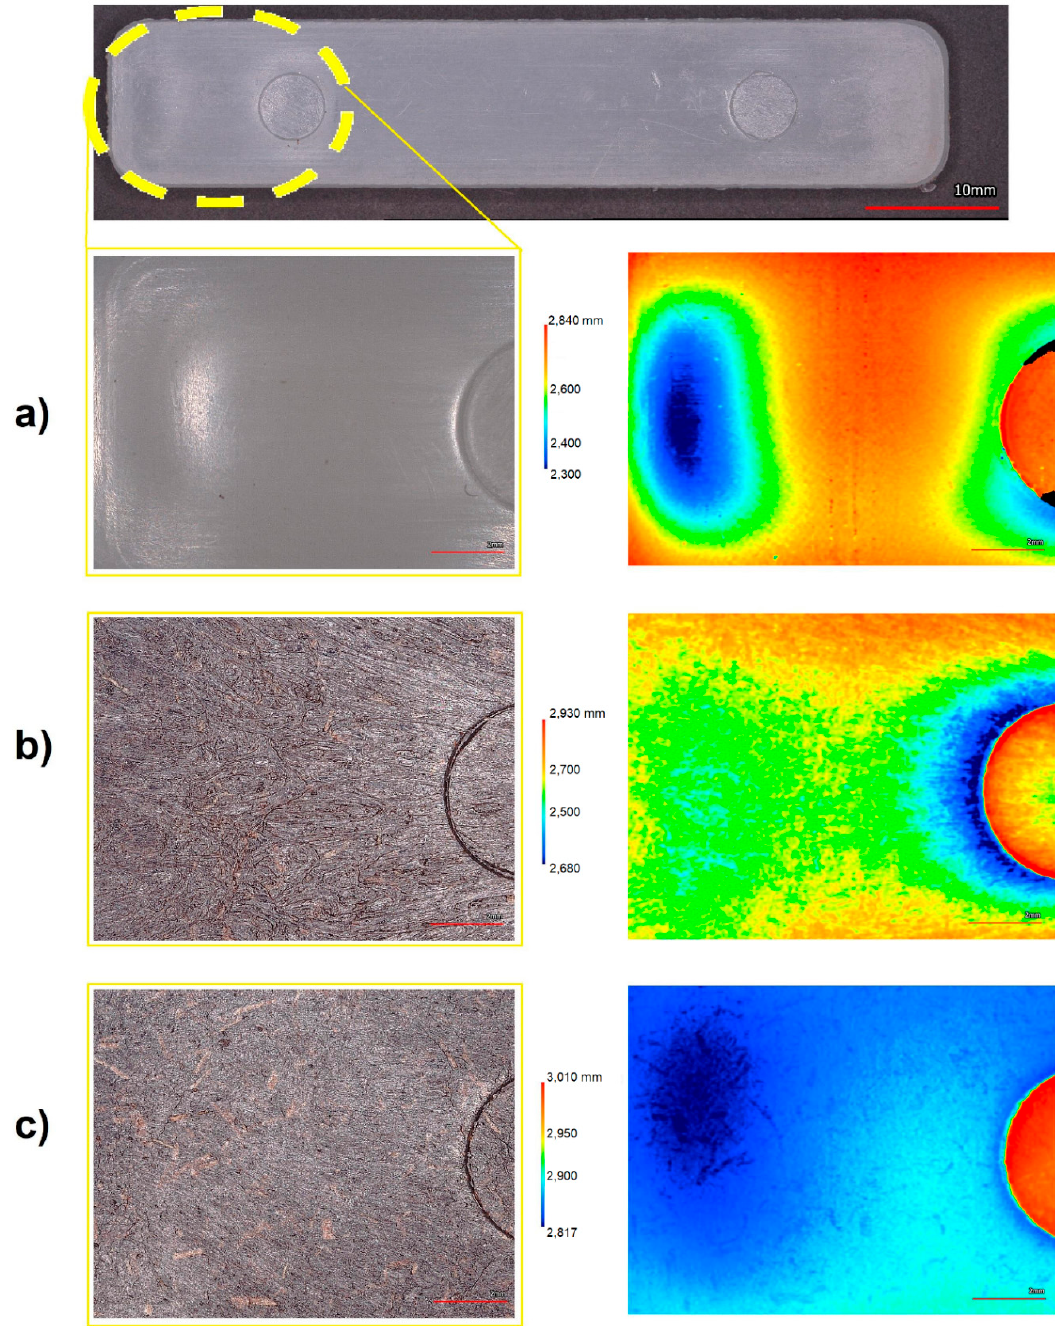
Figure 16. Surface characterization of ( a ) PP-HDPE blend ( b ) PP-HDPE-CCF 10 and ( c ) PP-HDPE-CCF 30 flexural specimens.